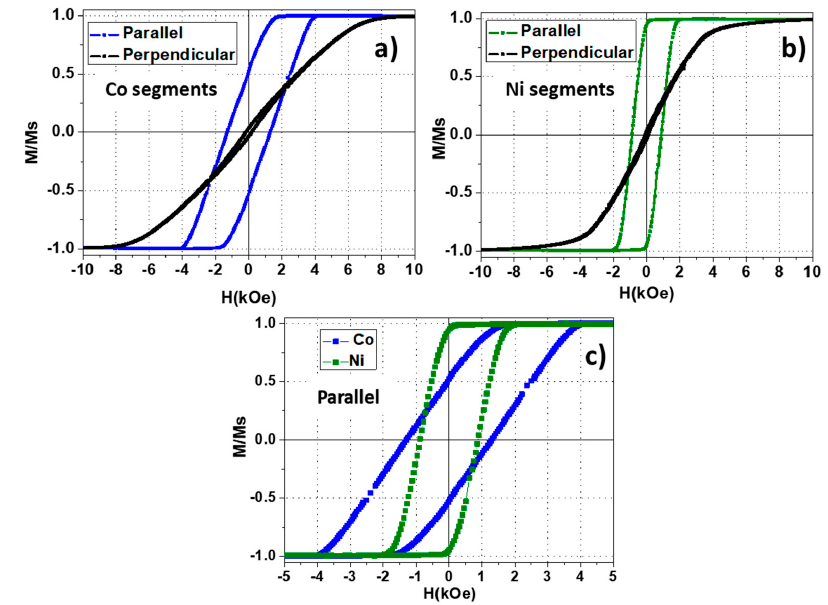
Figure 3. Room temperature hysteresis loops measured along the parallel and perpendicular (black) direction with respect to the nanowire long axis in ( a ) Co (blue) and ( b ) Ni (green) segment arrays. The comparison between the parallel hysteresis loops of Co and Ni segment arrays is shown in ( c ). To extract the intrinsic switching field distribution (SFD) of the Co and Ni nanowire arrays and evaluate the magnetostatic interaction among them, FORC analysis was performed on these samples. The parallel FORC diagrams of both samples are presented in Figure 4a,b. First, in the case of the Co